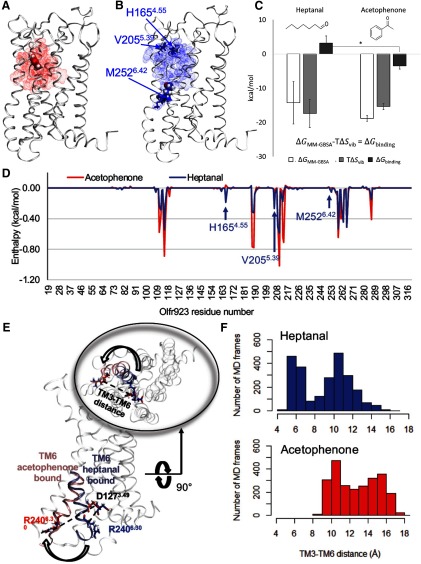
In silico investigation of ACT binding to olfr923. The three-dimensional structure of Olfr923 was built by homology modeling and bound to ACT (red, A) and heptanal (blue, B). Helices are represented in white ribbons and the odorant molecules are shown in Van der Walls volumes. The residues interacting with the odorant molecule during molecular dynamics simulations are highlighted by dotted clouds in the corresponding color (ACT-red, heptanal-blue). Residues specific to heptanal binding, H1654.55, V2055.39 and M2526.42 (Ballesteros–Weinstein numbering shown in superscript; Ballesteros and Weinstein, 1995), are represented in blue licorice. C, Computed enthalpy ΔGMM-GBSA, entropy TΔSvib, and free energy of binding ΔGbinding for heptanal and ACT bound to Olfr923; *p < 0.05 by paired t test (ACT compared with heptanal). N = 3 simulations per odorant. D, Decomposition per residue of the enthalpy ΔGMM-GBSA, for ACT (red) and heptanal (blue). E, Tridimensional structure of olfr923 in active and inactive conformations. The intracellular part of TM6 and the two residues involved in the ionic lock are highlighted for the ACT bound system (shade of red) and heptanal bound system (blue). Insert, Intracellular view of the receptor. The TM3-TM6 distance monitored in F is shown by a dotted line. F, Distribution of the number of frames in the molecular dynamics simulations sampling TM3-TM6 distances for ACT (red) and heptanal (blue). See Extended Data Figure 7-1 for GloSensor assay in vitro validation and the molecular dynamics workflow.